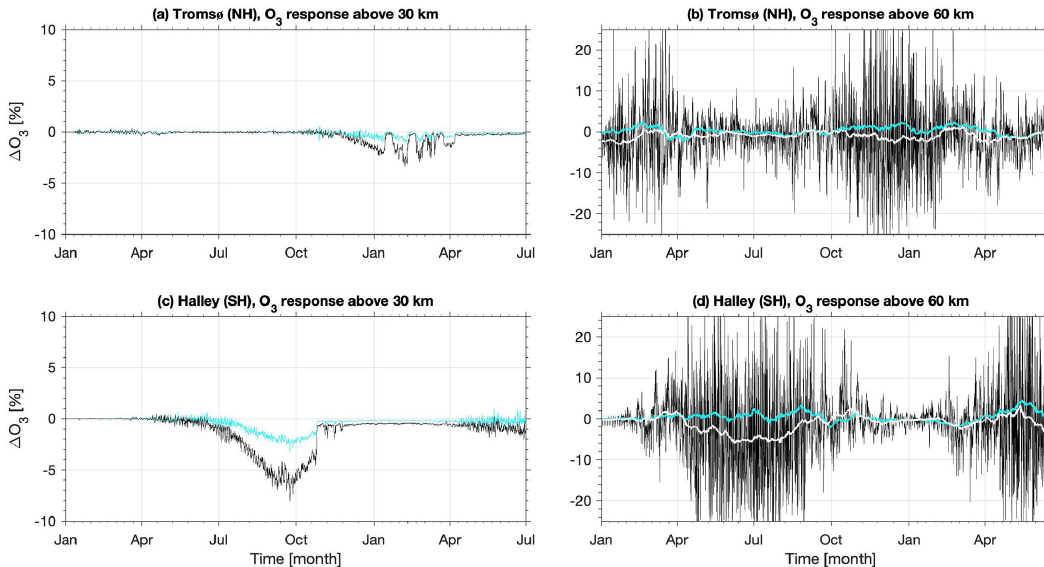
Figure 6. Height-integrated O 3 response to PsA EEP at the Tromsø and Halley stations. See the caption of Fig. 5 for